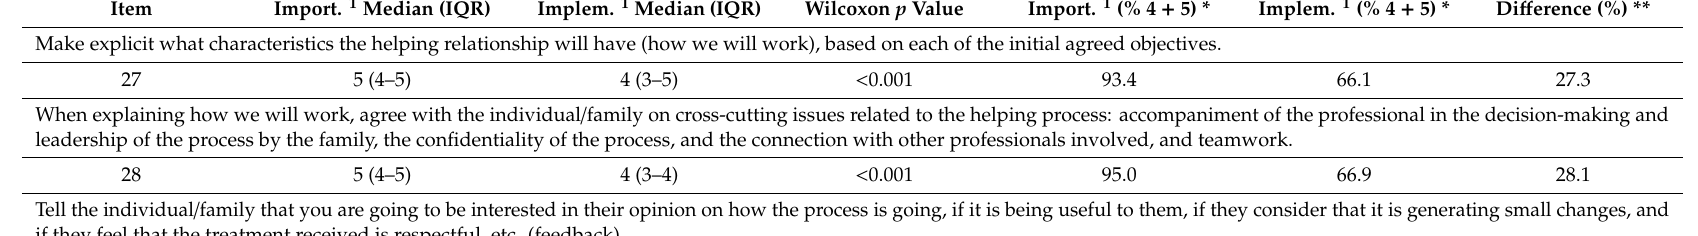
Table 4. Factor III: assessment of the agreement with the family on objectives and